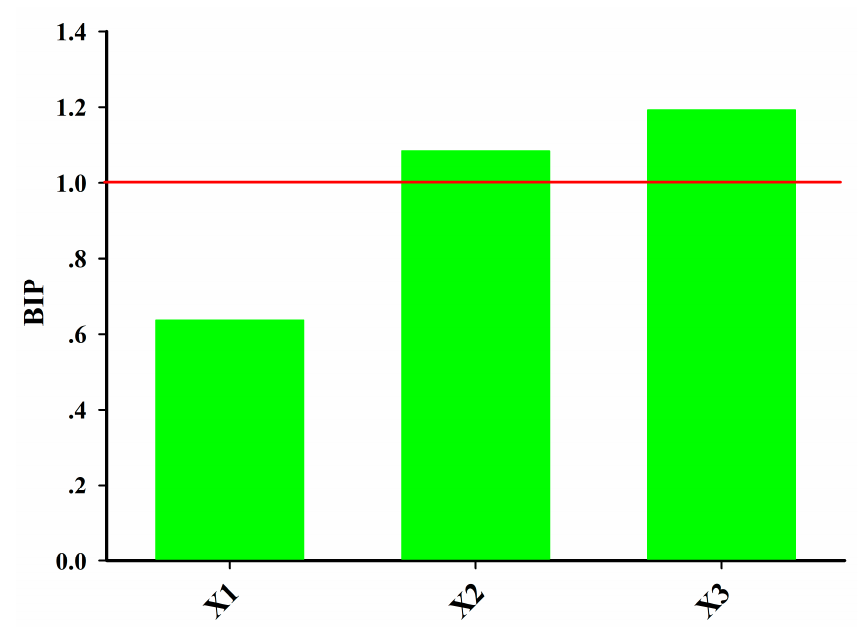
Figure 10. Block importance in the projection (BIP) index of each block in the MBPLSPM model.